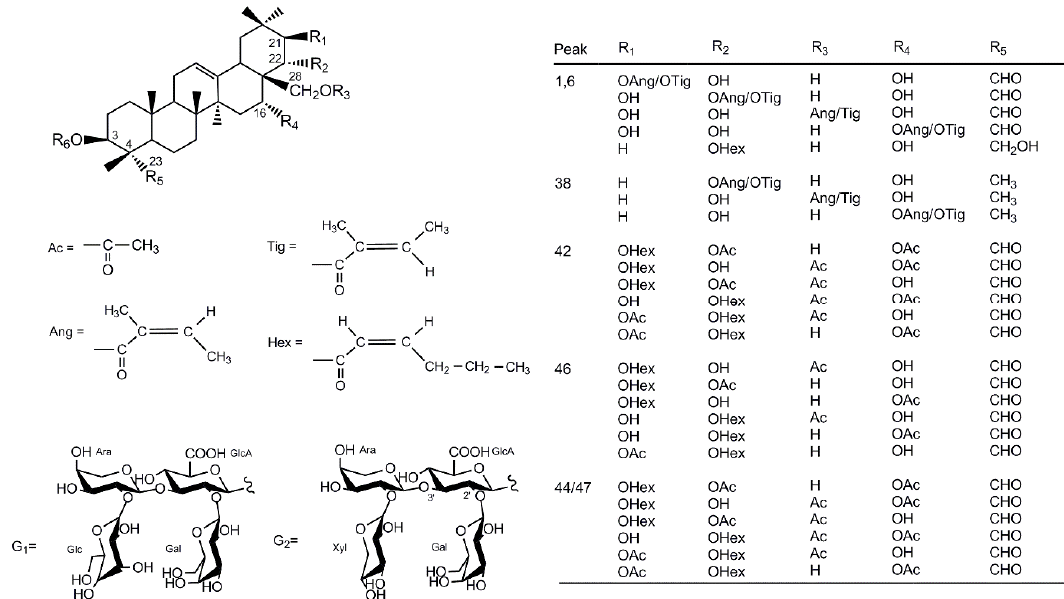
Figure 2. Possible chemical structures of the six potentially new saponins from the Camellia sinensis seeds. Ac = acetyl, Ang = angeloyl, Tig = tigloyl, Hex = hexenoyl, Ara = arabinopyranosyl, Gal = galactopyranosyl, Glc = glucopyranosyl, GlcA = glucuronopyranosyl, Xyl = xylopyranosyl. For five groups with ion [M − H] − at m/z 1173.5783–1173.5809 (peaks 15, 19), m/z 1231.5838– 1231.5873 (peaks 11, 14, 22), m/z 1261.5947–1261.5989 (peaks 9, 25), m/z 1273.5938–1273.5993 (peaks